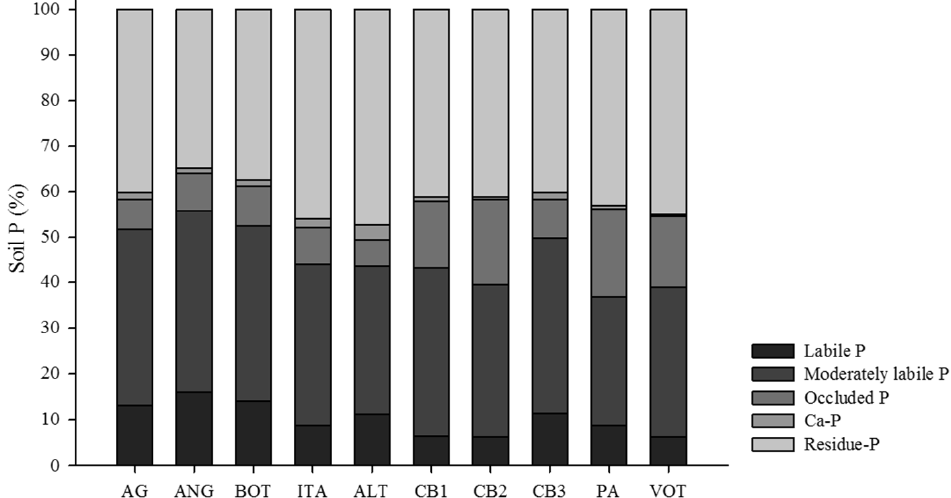
Figure 3. Soil P fractions for each Eucalyptus site as a percentage of total P. Sites: AG—Agudos, ANG—Angatuba, BOT—Botucatu, ITA—Itatinga, ALT—Altinópolis, CB1—Capão Bonito 1, CB2—Capão Bonito 2, CB3—Capão Bonito 3, PA—Paraibuna, VOT—Votorantim. Labile P (Resin ‐ Pi Sonicate+NaOH), Ca ‐ P (HCl ‐ Pi) and residue ‐ P.